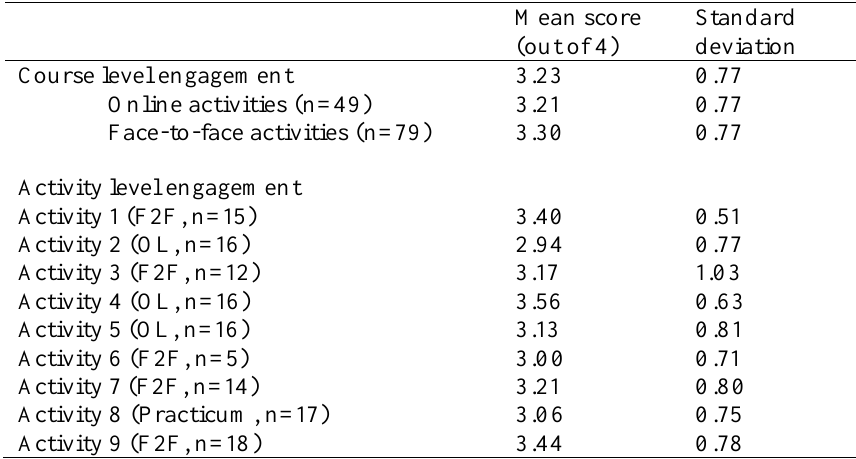
Table 2 Course and Activity Level